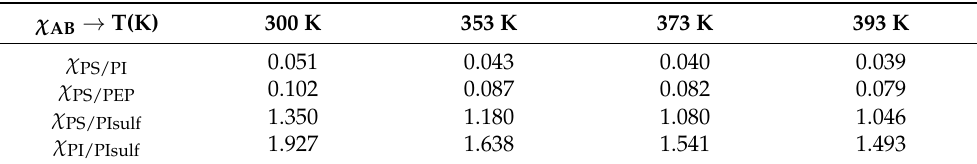
Table 1. Characteristic results for the χ AB between all block combinations concerning different chemical structures at different temperatures. χ AB →